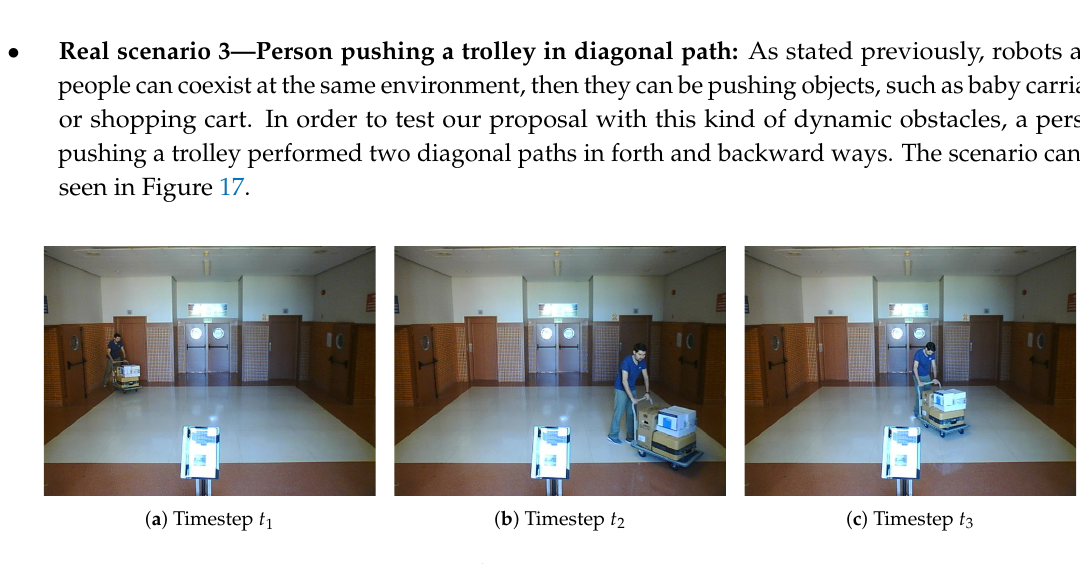
Figure 17. Real scenario 3—Images